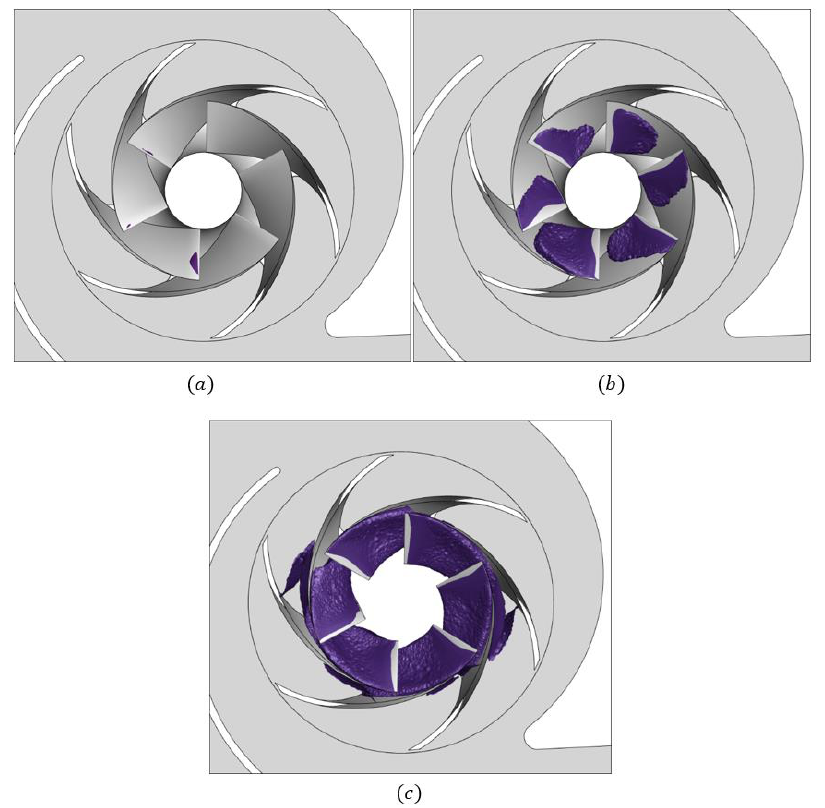
Figure 15. Iso-surface plot of volume fraction ( α = 0.1 ) at rated flow Q D : ( a ) NPSH = 20 m, ( b ) NPSH = 5.9 m, ( c ) NPSH3 .